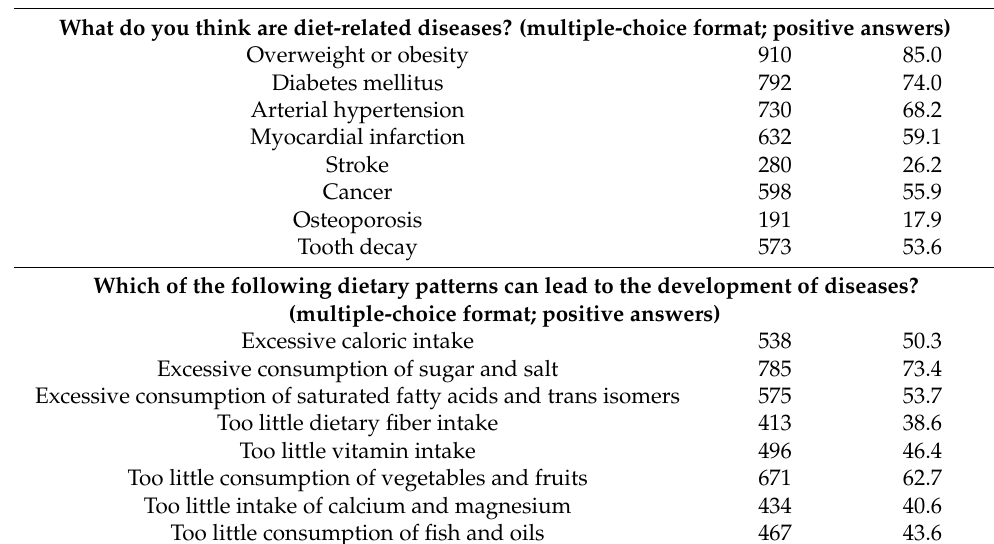
What do you think are diet-related diseases? (multiple-choice format; positive answers)